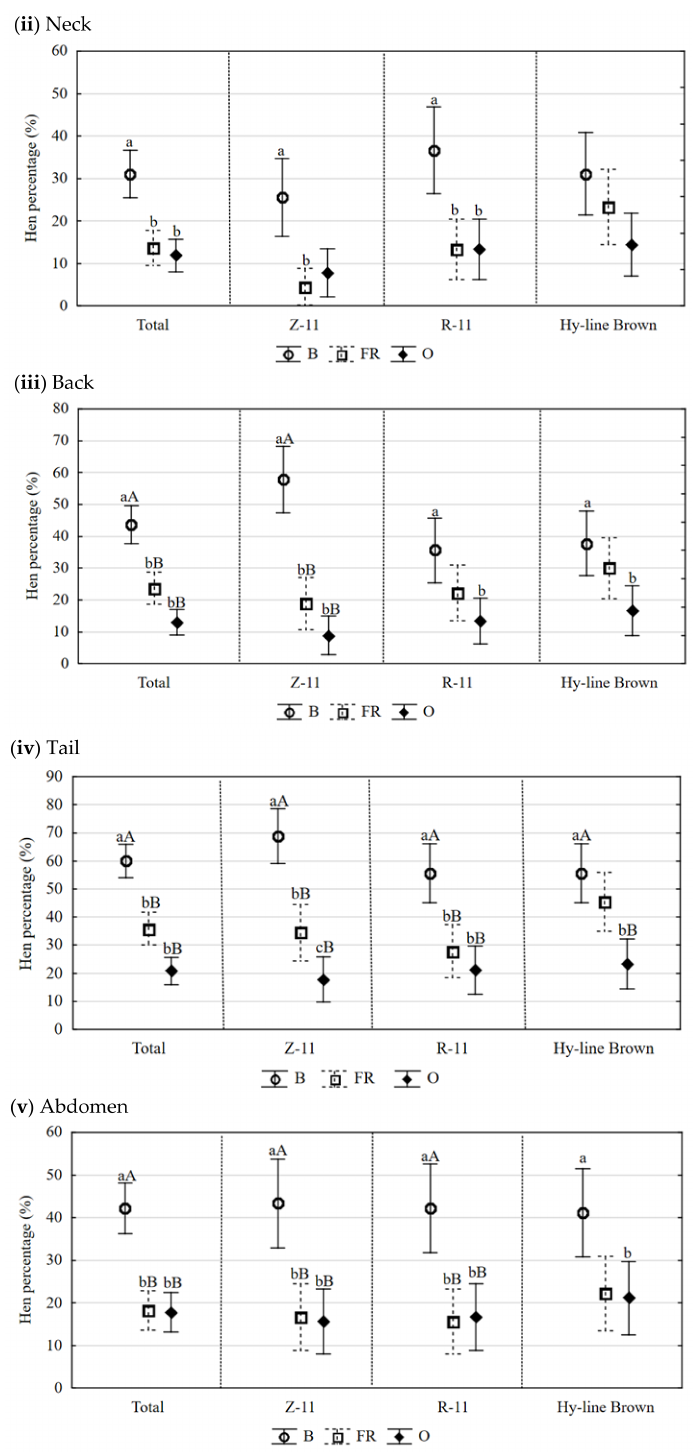
Figure 1. Effect of the type of alternative housing system on the share (%) of hens with feather defects in denoted parts of the body. Explanations: B—barn deep litter system; FR—free-range system; O—organic system; a, b, c—values in columns with various superscripts differ significantly within factors at p < 0.05; A, B —values in columns with various superscripts differ significantly within factors at p < 0.01. Total—for hens Z-11, R-11, and Hy-Line